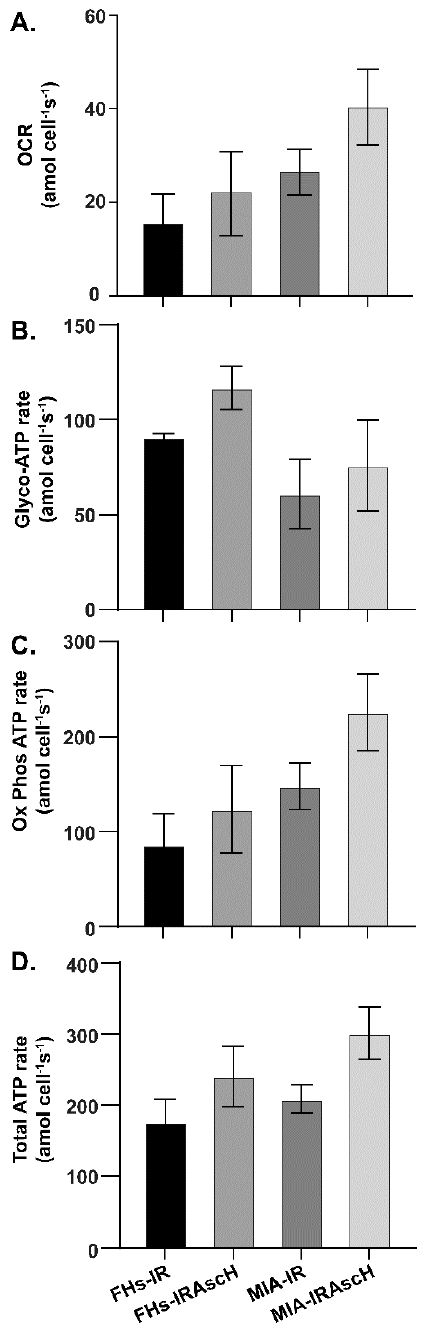
Figure 3. Bioenergetics after treatment with P-AscH − and radiation. In both normal and PDAC cell lines, P-AscH − (5 pmol cell − 1 , 1 mM) with and without radiation (5 Gy) results in increased rate of basal oxygen consumption (OCR) and increased rate of production of ATP 48 h after